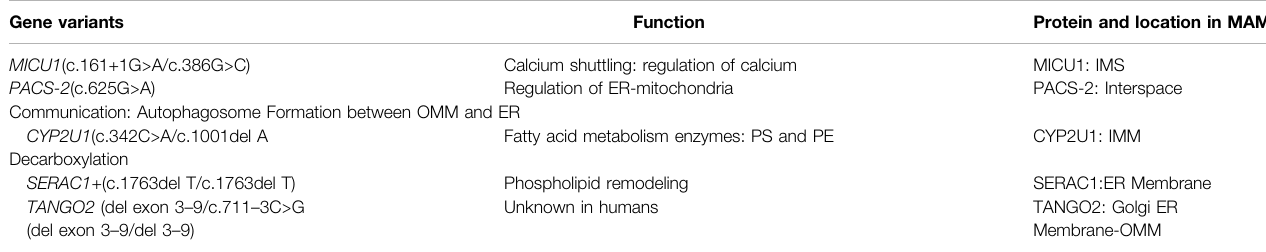
TABLE 1 | Gene variants and disease-related proteins involved in ER-mitochondrial coupling, MAMs Gene Variants Function Protein and Location in MAM.